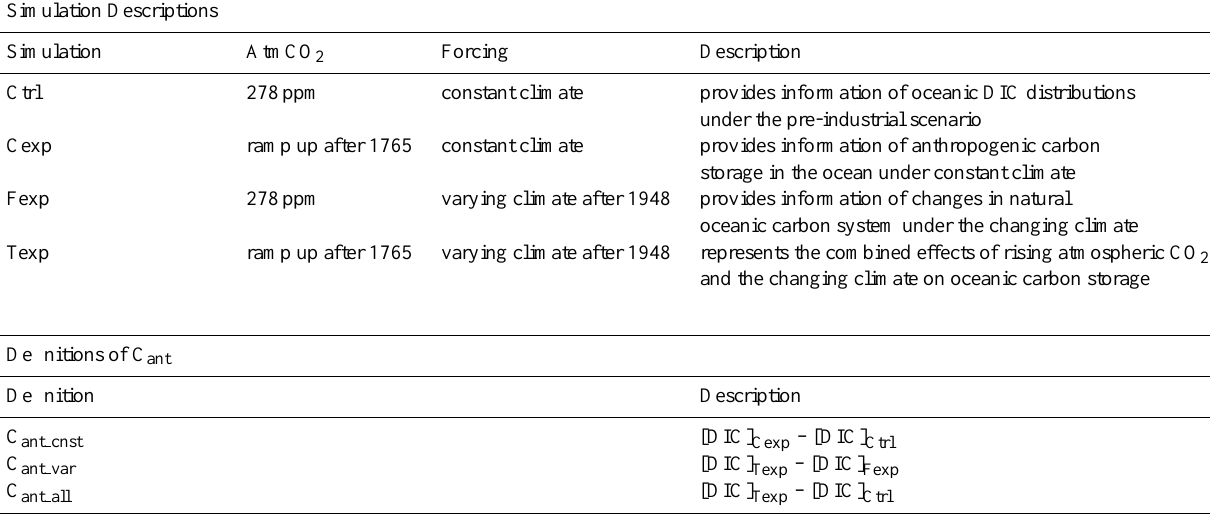
Table 1. Simulation descriptions and definition of C